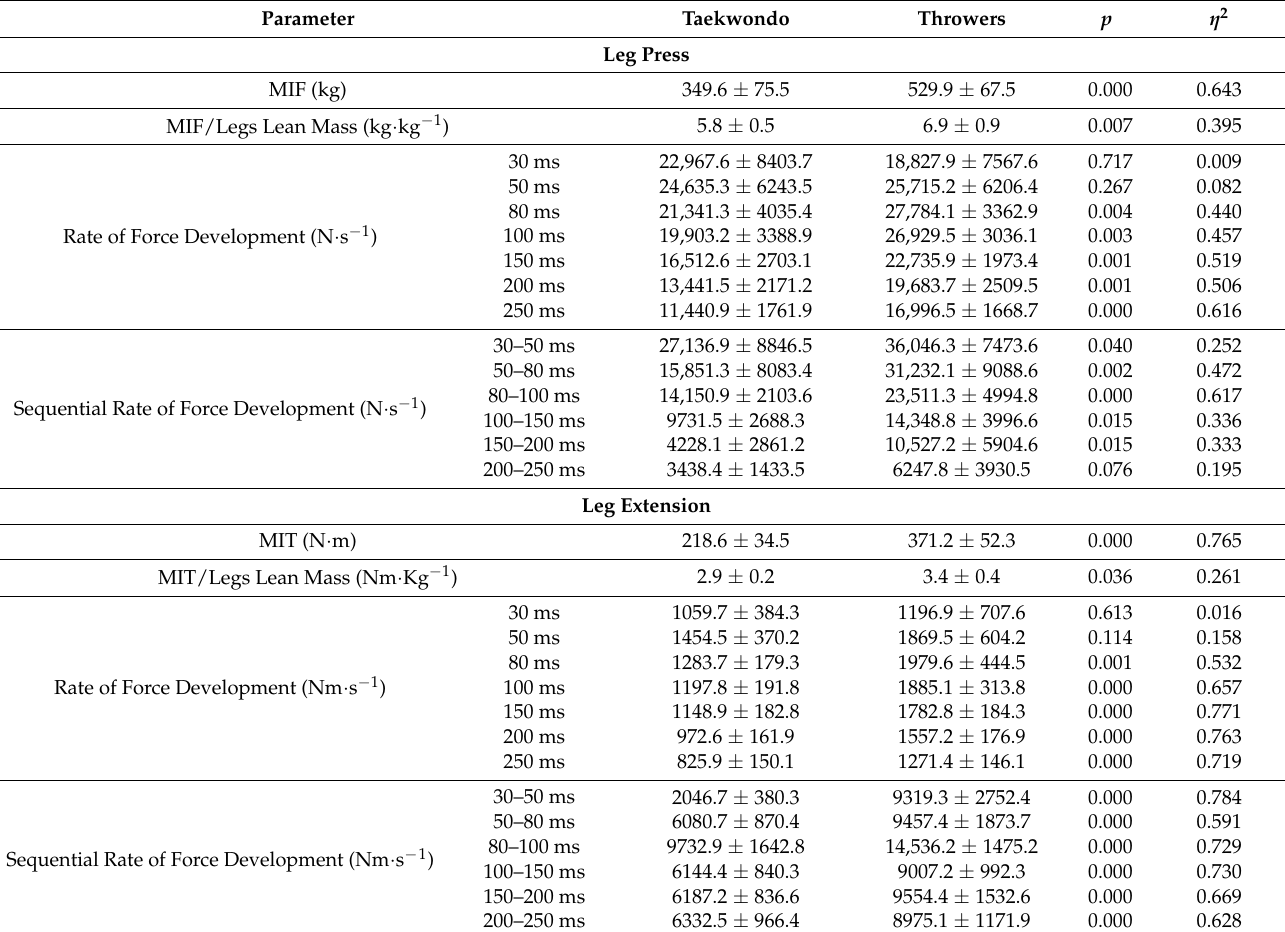
Table 2. Leg press and leg extension rate of force development, maximum isometric force/torque in taekwondo athletes and track and field throwers. Parameter Taekwondo